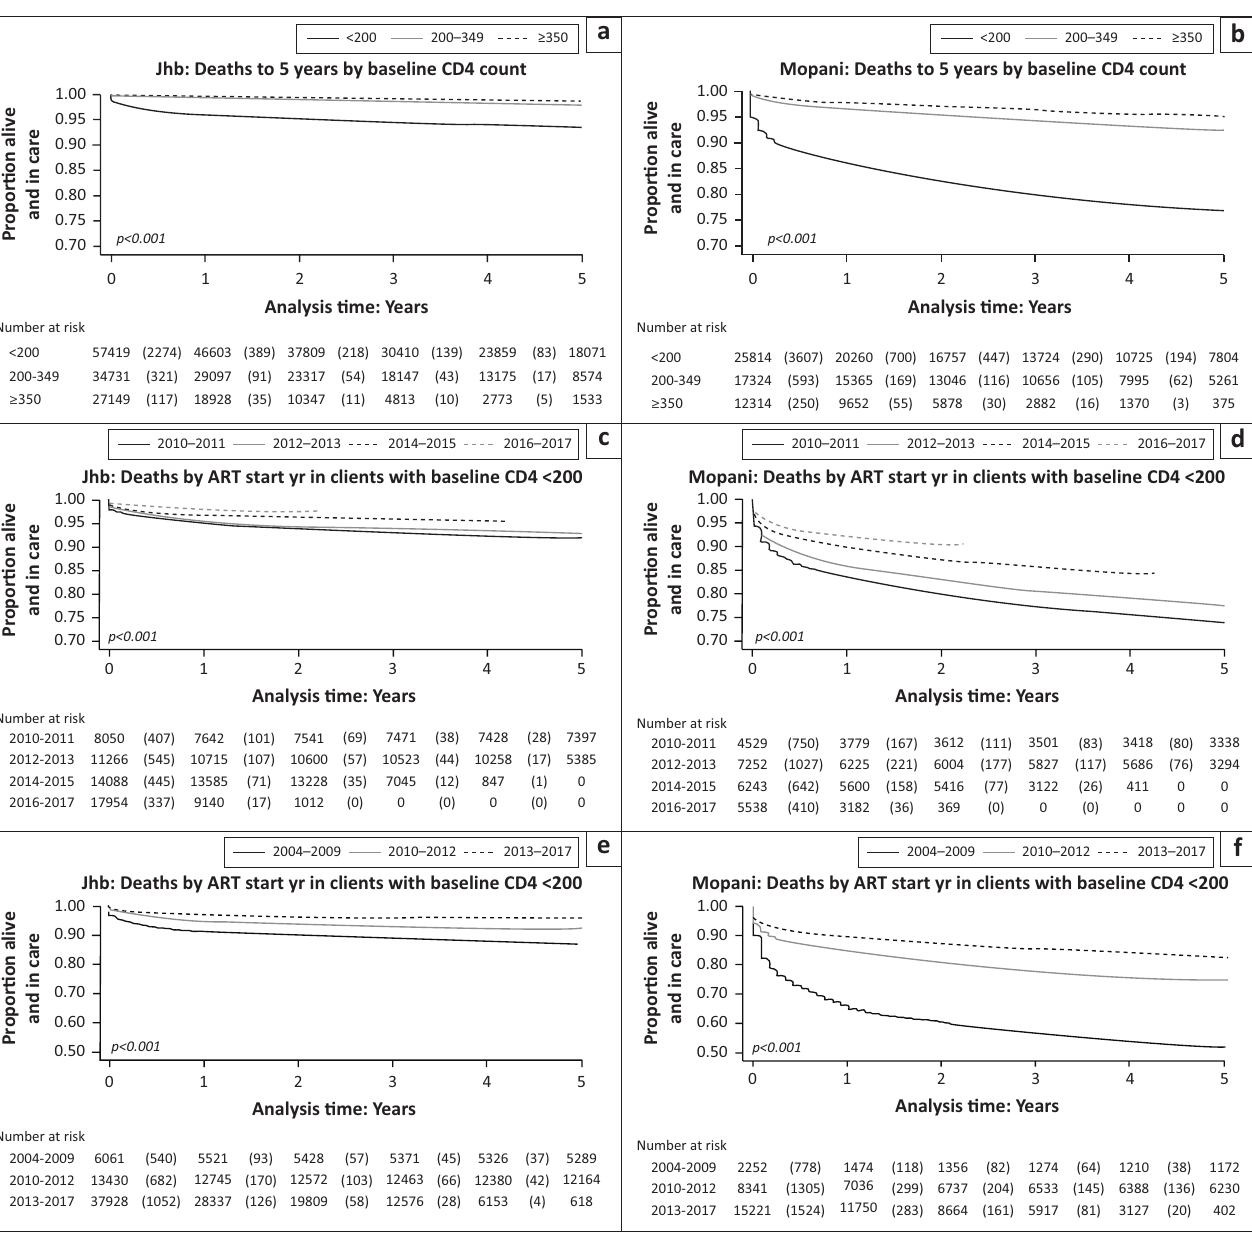
FIGURE 3: Kaplan–Meier survival curves of deaths to 5 years by baseline CD4 count in (a) Johannesburg and (b) Mopani. Deaths by year of antiretroviral therapy initiation among clients with baseline CD4 counts < 200 cells/mm 3 in (c) Johannesburg and (d) Mopani. Deaths by year of antiretroviral therapy initiation among clients with baseline CD4 counts < 200 cells/mm 3 where years have been grouped according to the timing of drug changes in the South African guidelines in (e) Johannesburg and (f) Mopani (2004–2009: single formulation regimens including stavudine; 2010–2012: single formulation regimens including tenofovir; 2013–2017: fixed-dose